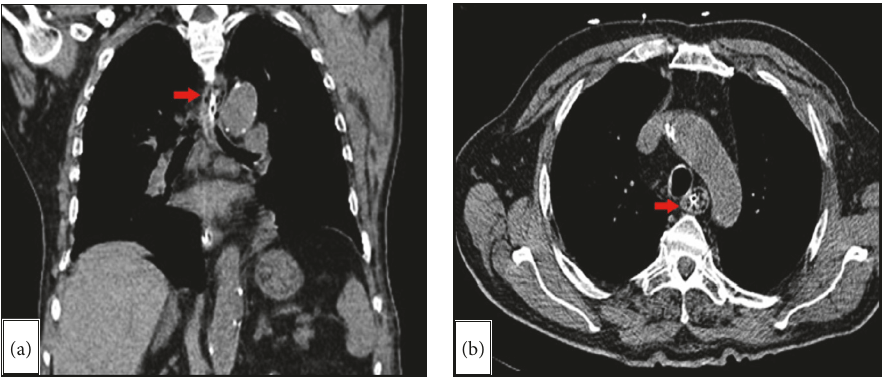
Figure 2: Computed tomography of the chest and upper abdomen ((a) coronal; (b) axial) with minimal administration of contrast through an NG tube, revealing the extent of the bezoar (red arrow) within the upper third of the esophagus.